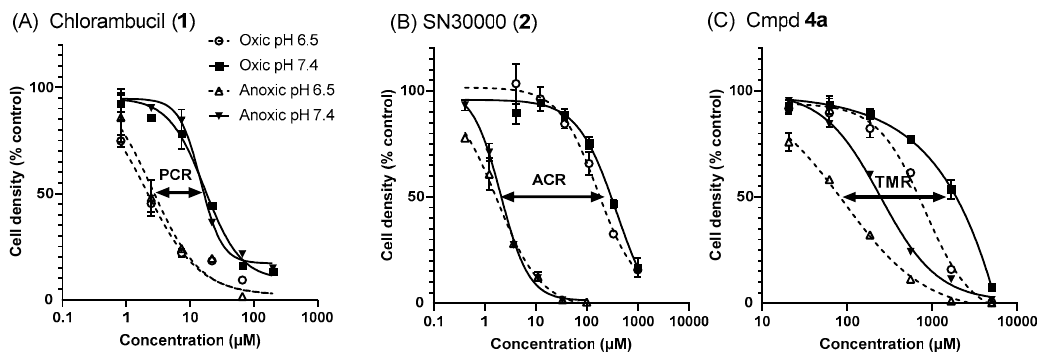
Figure 3. Representative data for the inhibition of proliferation of SiHa cells exposed to compounds for 4 h under oxia or anoxia at pHe 7.4 or 6.5. Cells were subsequently grown under standard cell culture conditions (oxia, pHe 7.4) for 5 days before staining with sulforhodamine B (SRB). ( A ) Chlorambucil ( 1 ). ( B ) SN30000 ( 2 ). ( C ) BTO acid 4a. Values are means and errors are ranges for duplicate cultures in a single experiment. Fitted curves are 4-parameter logistic regressions. PCR = pH cytotoxicity ratio. ACR = anoxia cytotoxicity ratio. TMR = tumor microenvironment ratio.